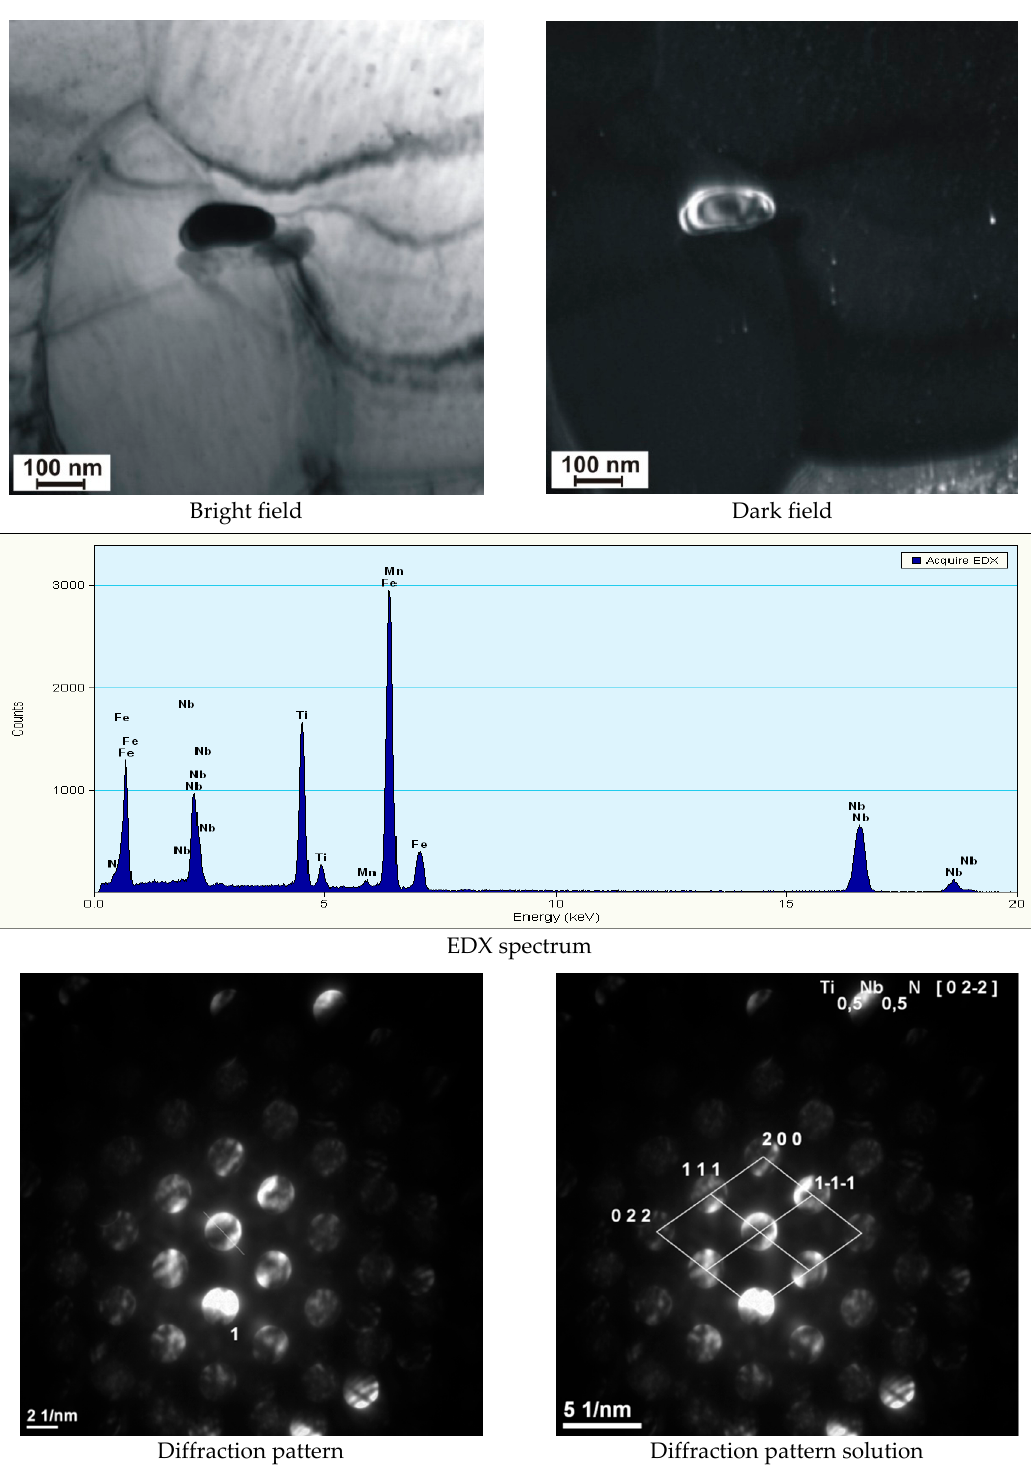
Figure 11. Coagulated separation precipitation of carbonitride (Ti,Nb)(C,N) in the HAZ of steel S700MC steel; welding was performed using the MAG method, a flux-cored wire, and a linear energy of 8 kJ/cm.